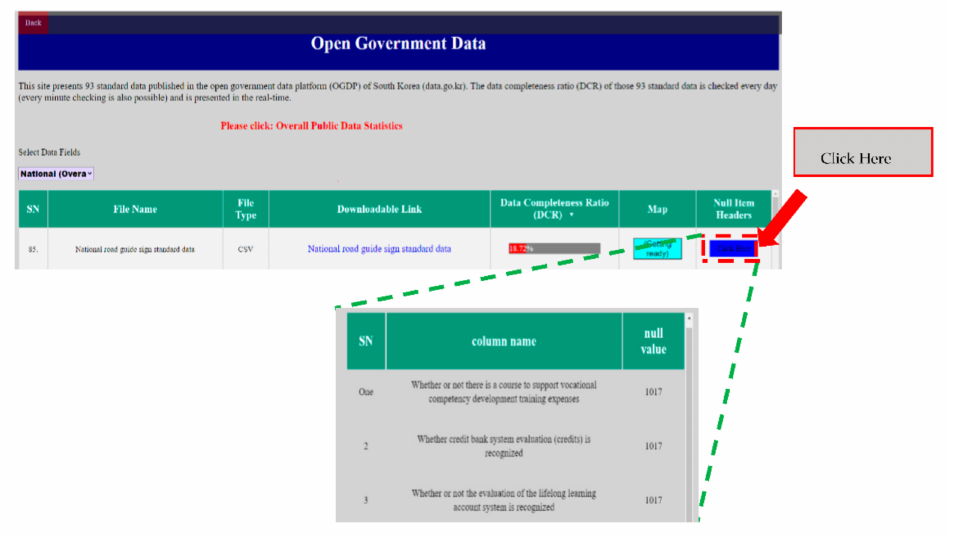
Figure 13. Dashboard showing sorted files based on the DCR value of OGD.